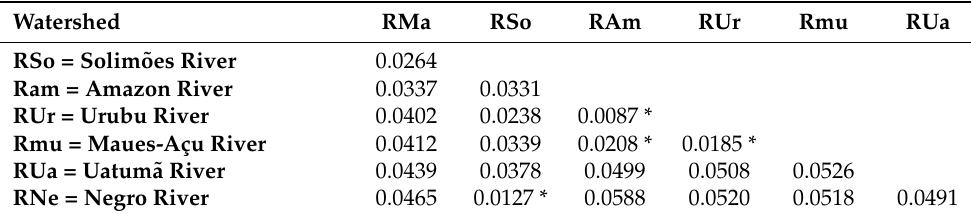
Table 4. Pairwise comparisons of F ST among the seven watersheds where the 15 populations of A. aculeatum were collected in the state of Amazonas. Watershed RMa RSo RAm RUr Rmu RUa RSo = Solim õ es River 0.0264 Ram = Amazon River 0.0337 RUr = Urubu River